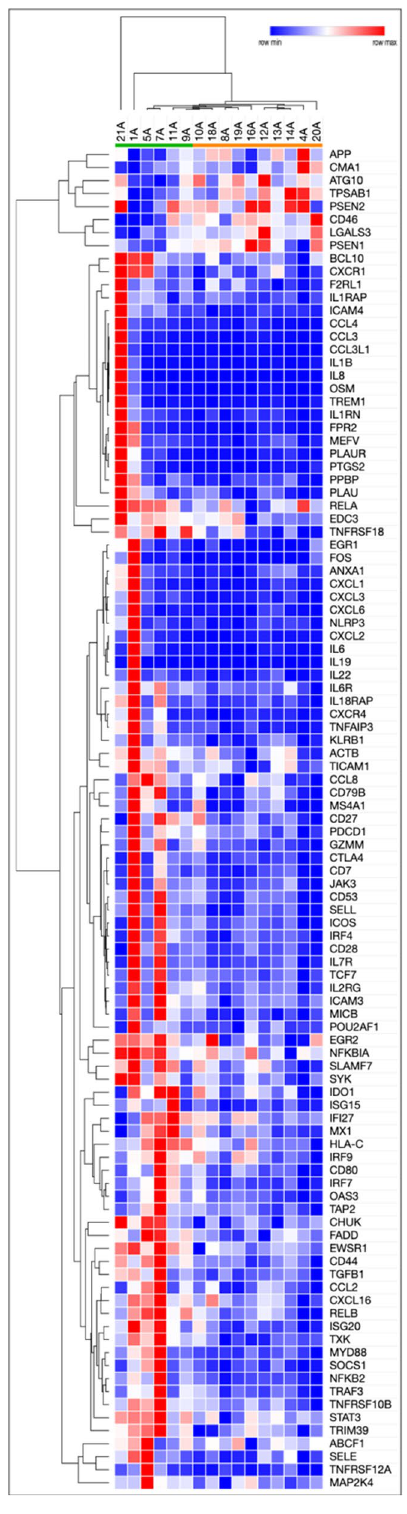
Figure 3. Heatmap of 103 genes differentially expressed between complete responders and incomplete responders. Data shown is pre-treatment gene expression for genes that are differentially expressed between CR and IR. Blue indicates a lower expression, red indicates a higher expression. Heatmap was generated using Morpheus v.1 Software. URL: https:// softw are. broad insti tute. org/ morph